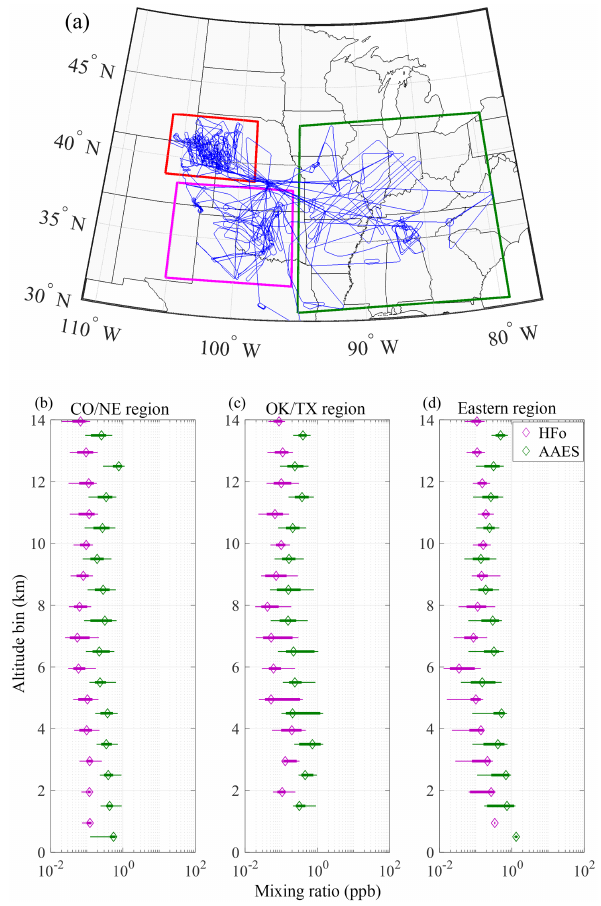
Figure 6. (a) Map of three DC3 flight domains: Colorado–Nebraska (red), Oklahoma–Texas (magenta), and Eastern region (green) along with the HIAPER flight tracks. (b) Profiles for the HFo and AAES mixing ratios as a function of altitude for the three DC3 study regions (Colorado–Nebraska (CO / NE), Oklahoma– Texas (OK / TX), and Eastern Region). The symbols represent the median value for each altitude bin, the thick lines the interquartiles, and the thin line is the 10th–90th percentile.